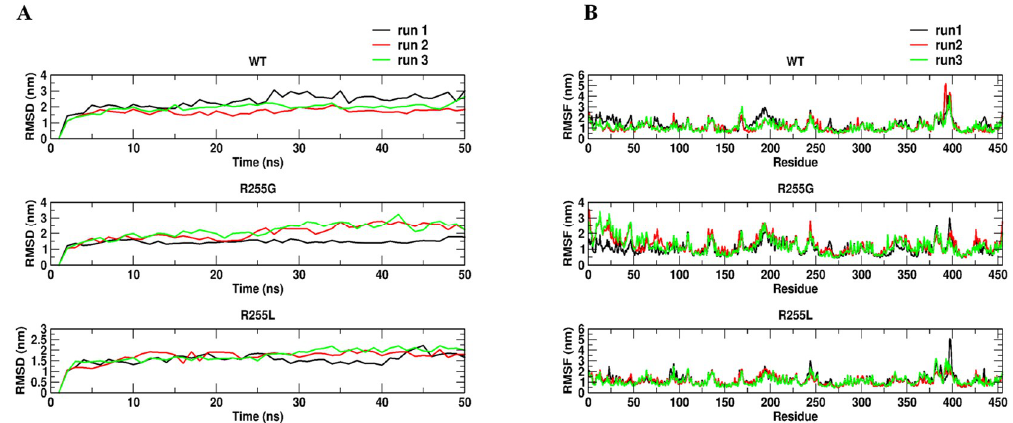
Figure A16. Calculated ( A ) root mean square deviation (RMSD) and ( B ) root mean square fluctuation (RMSF) per residue of P450 BM3 WT and P450 BM3 variants (R225L and R255L) throughout three independent MD simulation runs (I-helix: residues 245 to